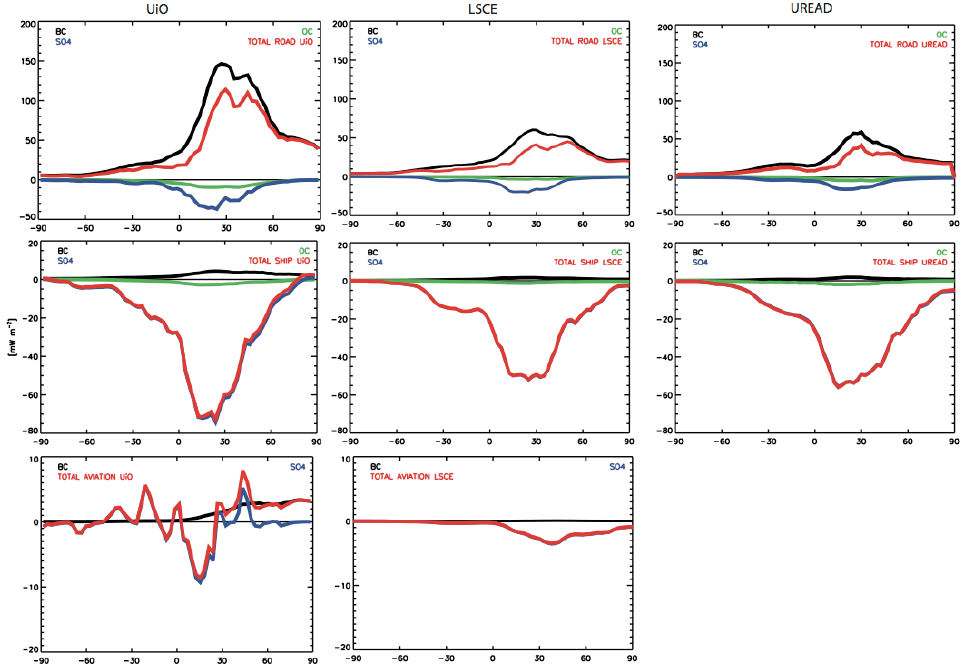
Figure 3. Fig. 3. Zonal-mean all-sky radiative forcings (mWm − 2 ) of the direct aerosol effect from the three models. The panels are presented in the same order than in Fig. 2. As in Fig. 2, the radiative forcing from UiO model is presented for BC internally mixed with the other components of the aerosols, whereas the radiative forcings for LSCE and UREAD models are presented for an external mixture of